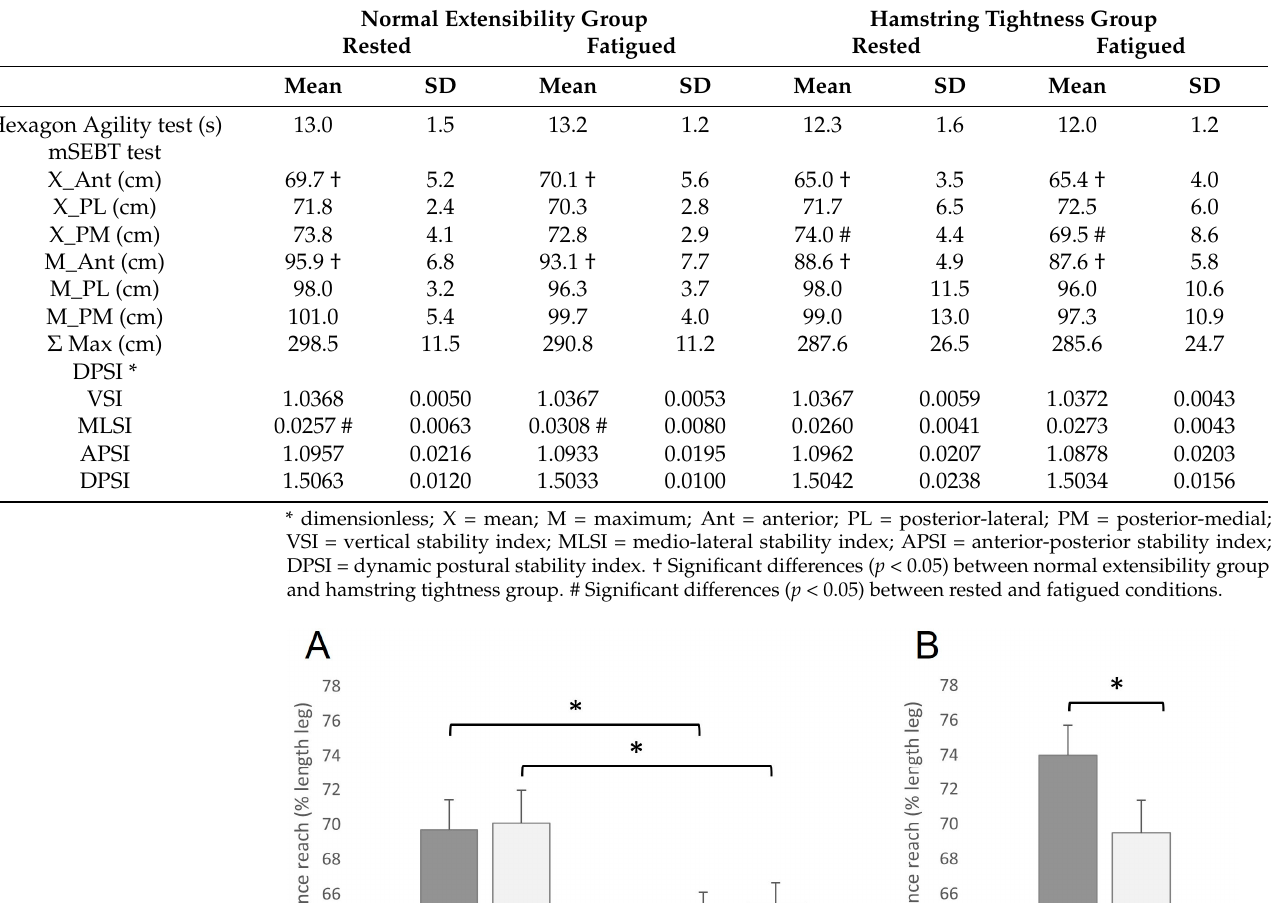
Table 2. Descriptive results of group (NEG vs. HTG) and fatigue (rested vs. fatigued) effects on agility and dynamic stability variables.